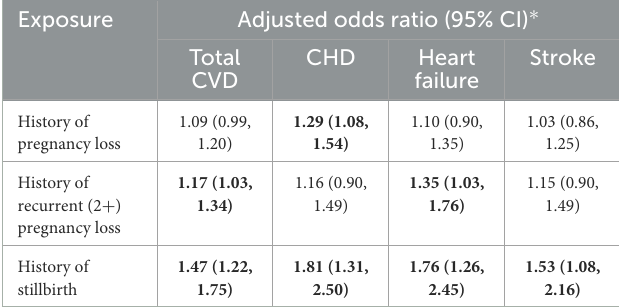
TABLE 2 Odds of incident cardiovascular disease (CVD) within 5 years of baseline in WHI participants aged 50–79 with and without a history of pregnancy loss, recurrent pregnancy loss, and